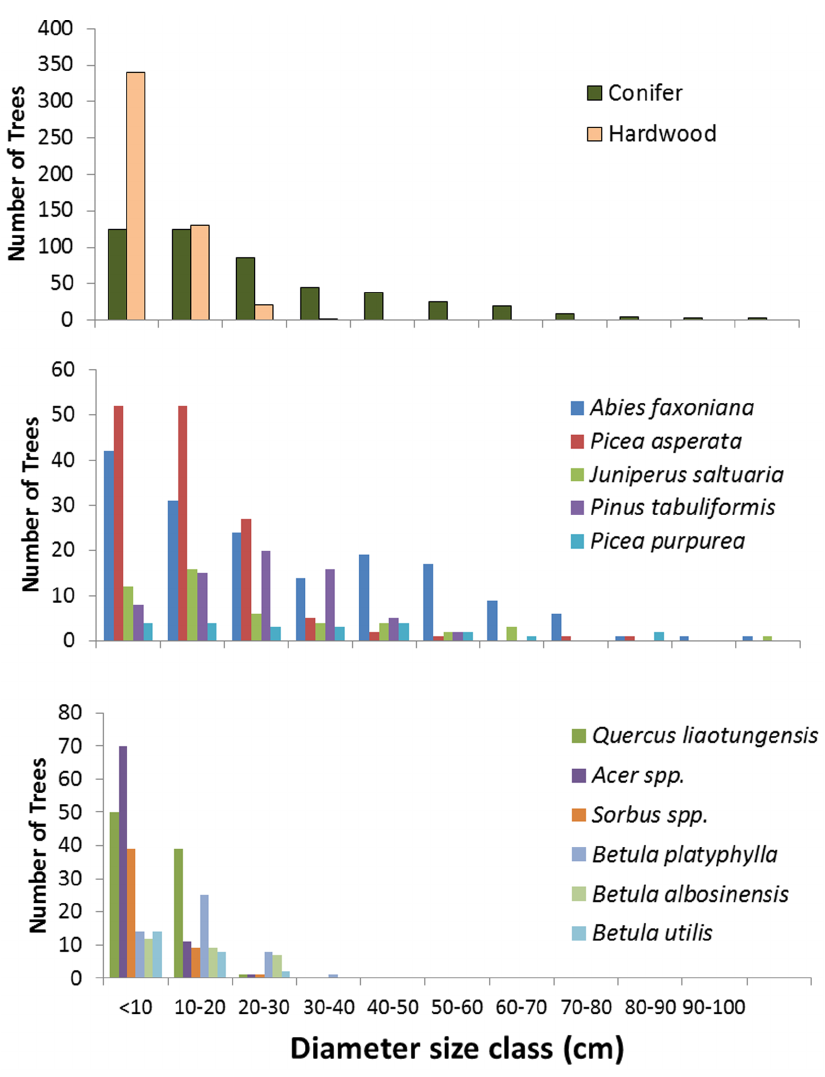
Figure 3. Forest composition for Jiuzhaigou National Nature Reserve. Tree diameter at breast height (dbh) class distributions in 39 forest plots (approximately 2.75 ha) distributed across the Jiuzhaigou National Nature Reserve. (A) Canopy trees divided into conifer and hardwood categories, showing a strong dominance by conifers among large diameter trees. (B) Diameter class distributions of the five most abundant conifer tree species. (C) Diameter class distributions among the dominant hardwood taxa, mostly defined to the generic level. Diameter class categories by 10 cm intervals for all trees greater than 2 cm dbh.